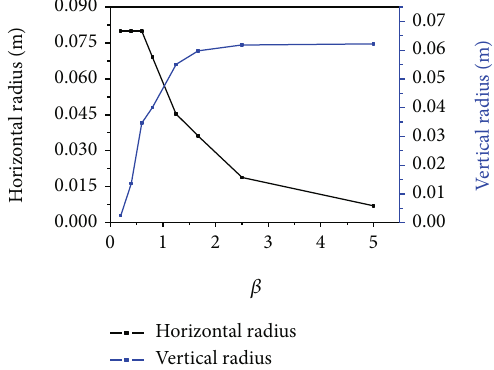
Figure 9: The horizontal radius and vertical radius of hydraulic fractures under di ff erent stress